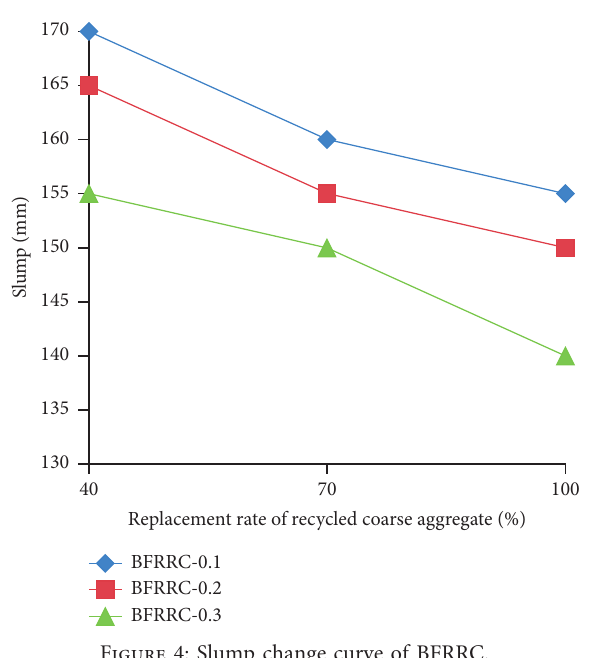
Figure 4: Slump change curve of BFRRC.